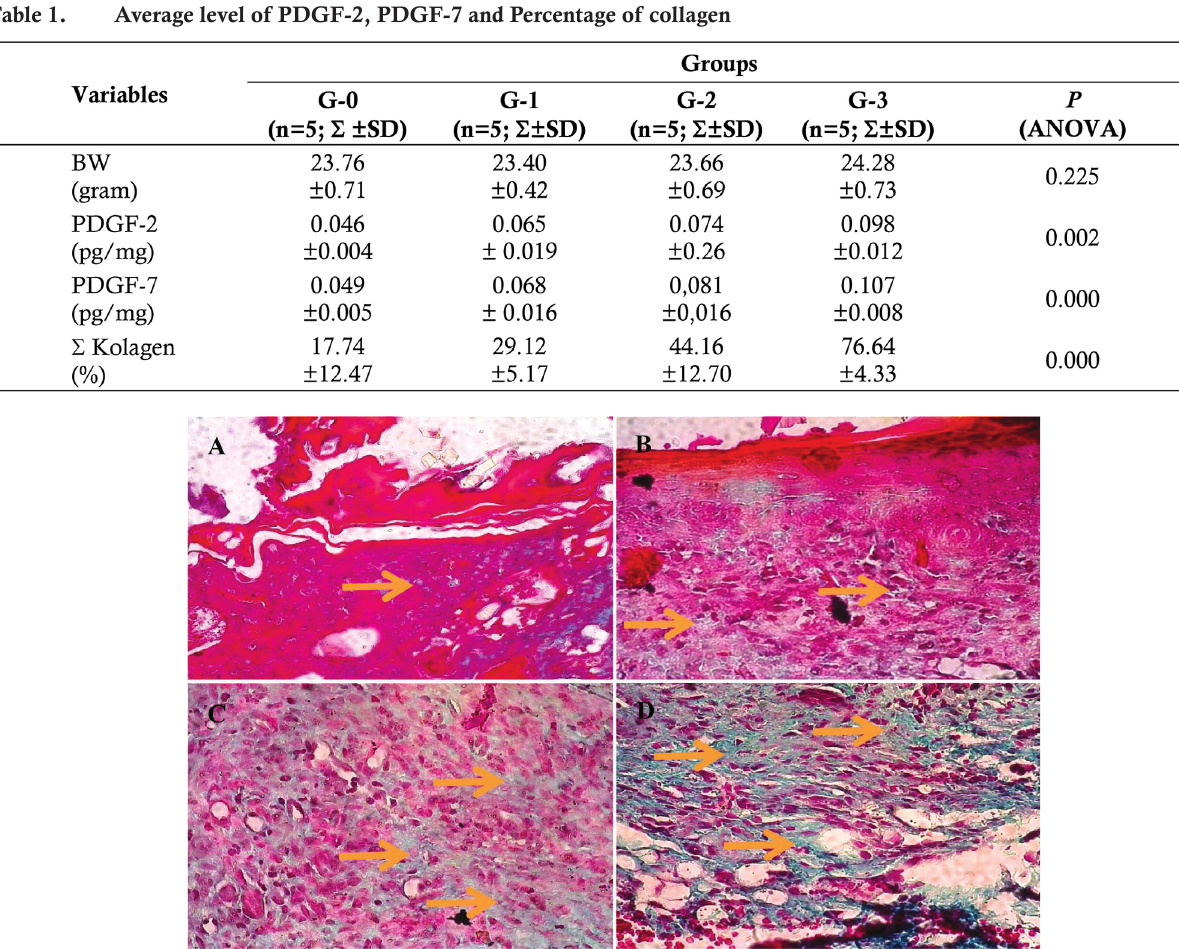
Figure 1. Collagen (bluish green) using Masson’s Trichrome. A: G-0, B: G-1, C: G-2, and D: